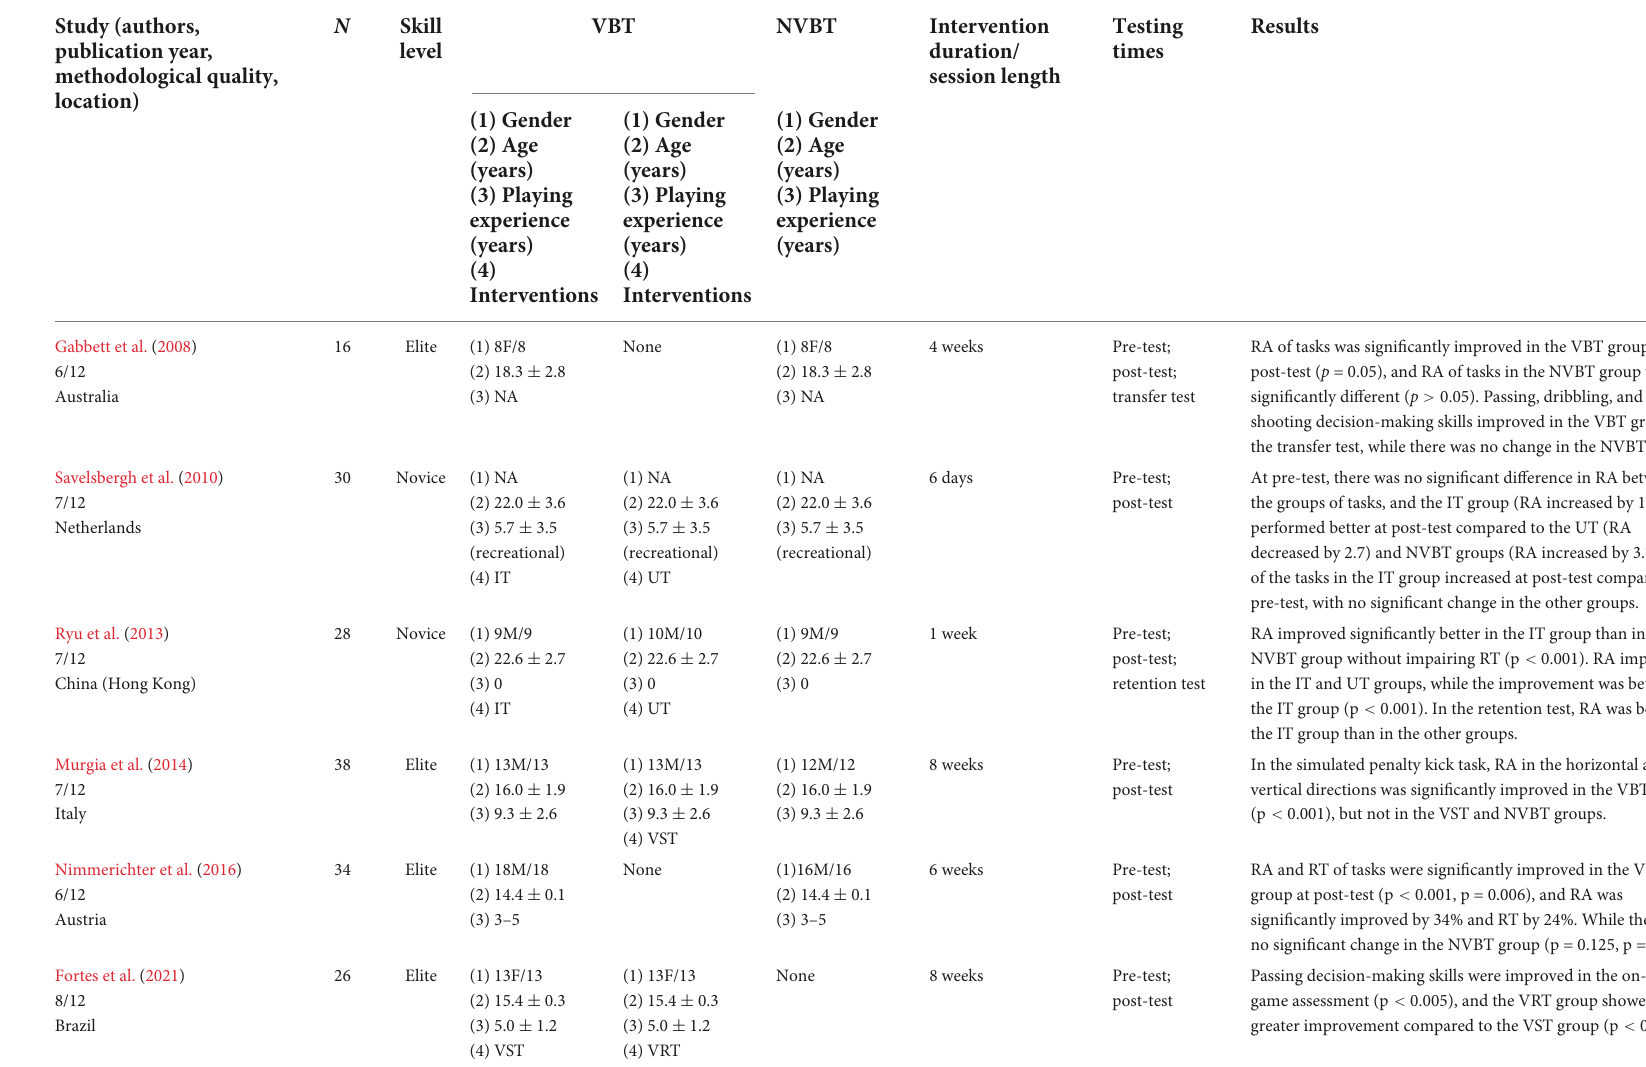
TABLE 1 Characteristics of the included longitudinal